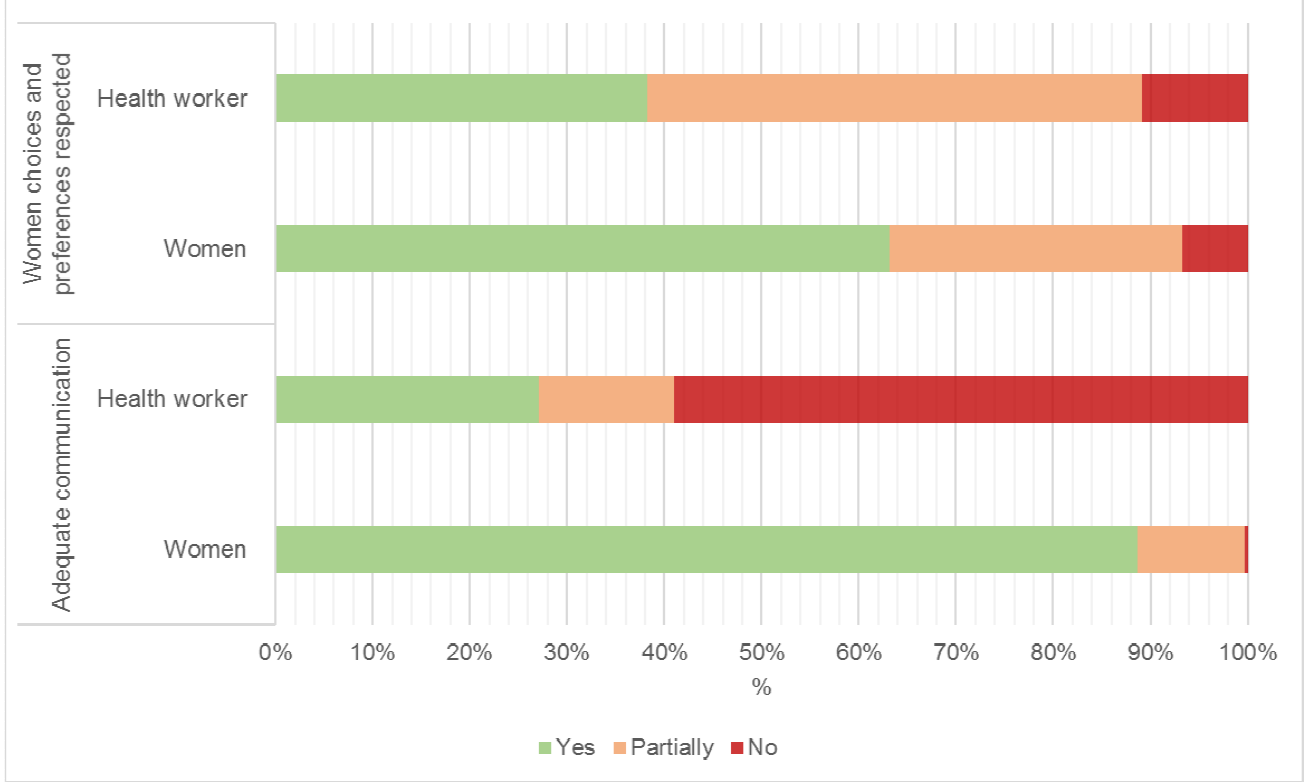
Figure 2. Communication and respect for women choices and preferences according to either women or health workers’